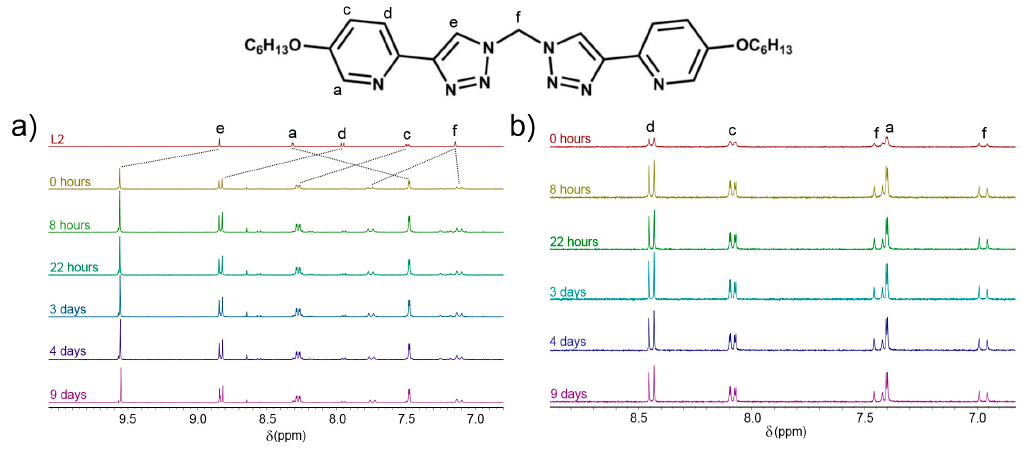
Figure 2. Partial stacked 1 H-NMR spectra (400 MHz, 298 K) of ( a ) [Co 2 L2 3 ](OTf) 6 in d 6 -DMSO in the dark and ( b ) [Co 2 L2 3 ](OTf) 6 in D 2 O in the light. (Note: H d is not observed in the D 2 O spectrum due to hydrogen-deuterium exchange, and the ligands are not soluble in D 2 O).